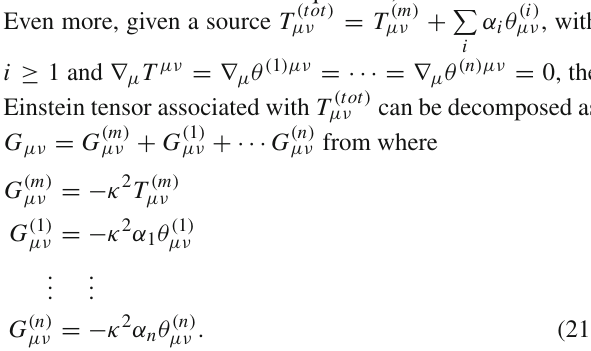
Fig. 1 Circularly symmetric space–time filled with both θ μν and cos- mological constant (cid:10) . Note that the case θ μν = 0 yields BTZ black